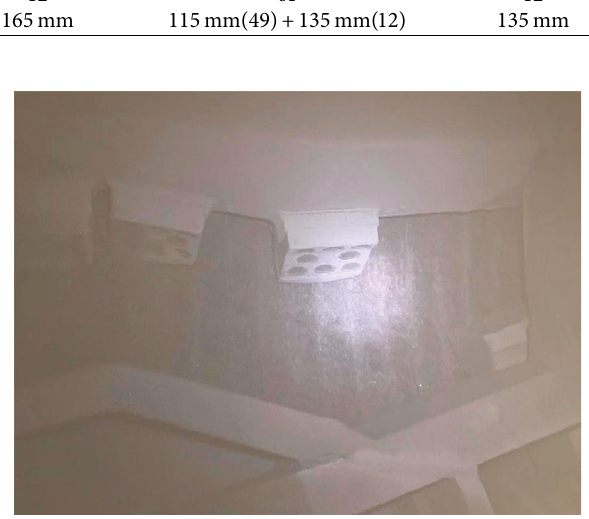
Figure 4: Cutting